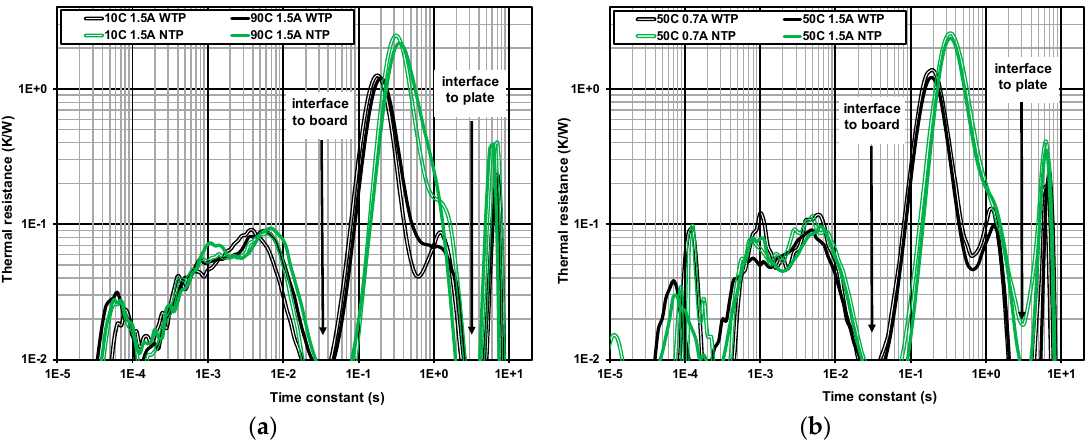
Figure 4. Computed thermal time constant spectra: ( a ) results for heating current of 1500 mA and cold plate temperature values 10°C and 90°C; ( b ) results for heating currents of 700 mA and1500 mA for cold plate temperature 50°C.